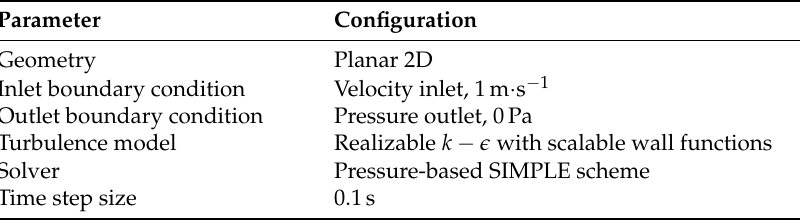
Table 2. Simulation parameters for ANSYS Fluent